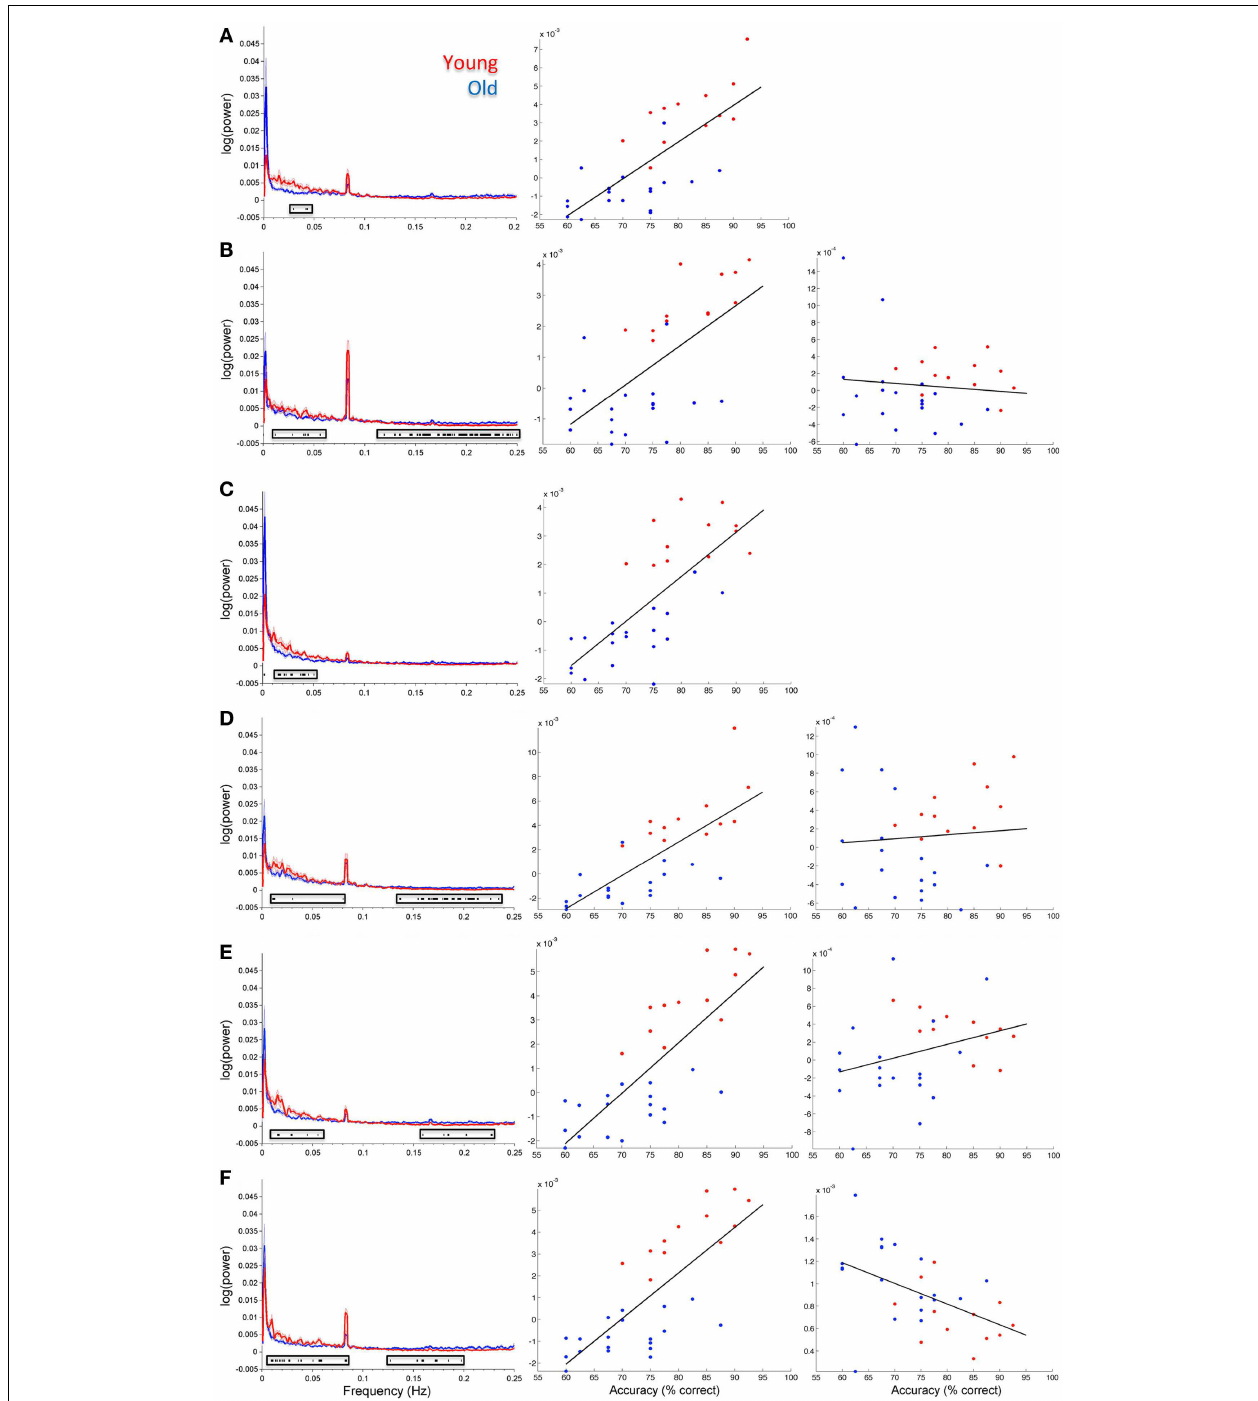
out of the data. Middle column shows correlations for significant frequency points at lower frequencies ( < 0.1Hz).The right column shows correlations for significant frequency points > 0.1Hz. (A) Putamen (IC 14), (B) Visual cortex (IC 15), (C) right STG (IC 26), (D) precuneus (posterior DMN; IC 48), (E) left insula (IC 63), (F) cingulo-insula network (salience network; IC 65). In all plots red refers to young participants and blue to